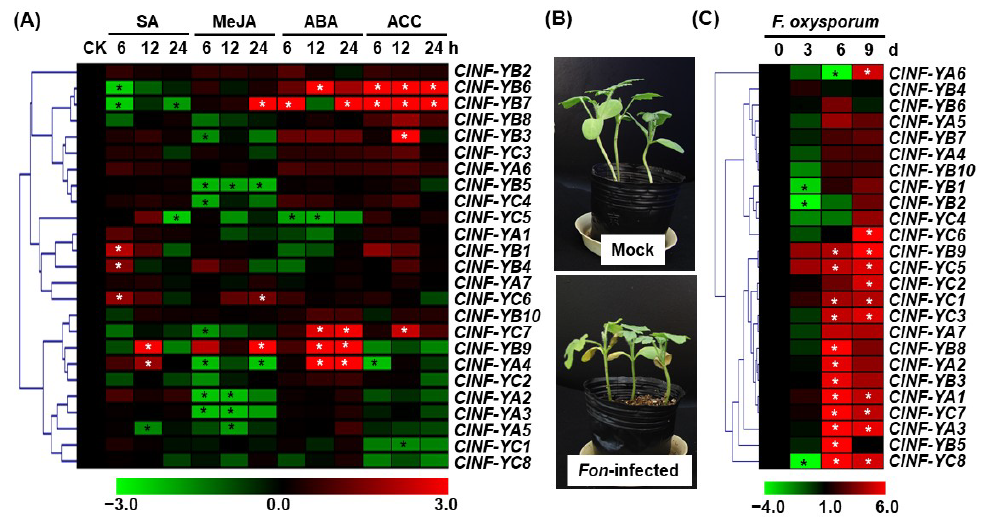
Figure 7. Expression changes of the watermelon ClNF-Y genes in response to hormones and F. oxysporum f. sp. niveum . ( A ) Expression changes of the ClNF-Y genes in response to SA, MeJA, ABA, and ACC. Four-week-old watermelon plants were treated by foliar spraying with 1 mM SA, 100 μM MeJA, 100 μM ABA, 100 μM ACC, or a similar volume of solution (as mock controls) and leaf samples were collected at indicated time points after treatment. ( B ) Disease phenotype of the Fon-inoculated plants at 11 d post-inoculation. ( C ) Expression changes in the ClNF-Y genes in the roots of watermelon plants after infection by F. oxysporum f. sp. niveum . Three-week-old plants were inoculated by dipping the roots in spore suspension (1 × 10 7 spores/mL) of F. oxysporum f. sp. niveum or in mung bean liquid broth as mock-inoculated controls, and root samples were collected at indicated time points after inoculation. RT-qPCR was performed using the watermelon ClGAPDH gene as an internal control and relative expression levels are presented as log 2 (FoldChange). Experiments were performed three times and data presented are the means from three independent experiments. * indicates the significant difference at the p < 0.01 level compared to the data in mock-treated ( A ) and mock-inoculated ( C ) plants at 0 h or 0 d, respectively.